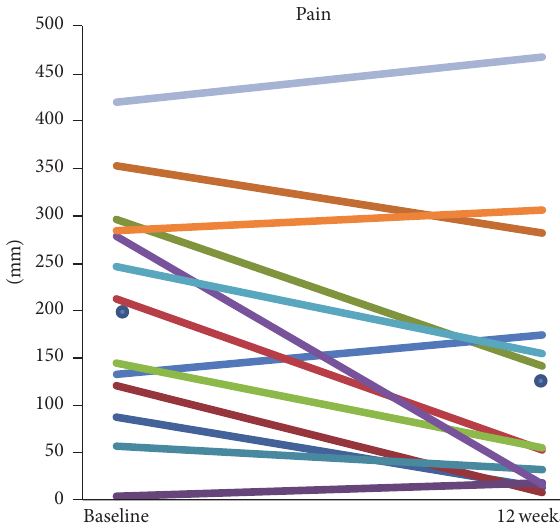
Figure2:IndividualchangesintheWOMACpainscorein12weeks. The mean (SD) pain score at the baseline and 12-week time point is marked with a dot being 202 (123)mm and at 12-week time point 131 (143)mm, respectively (reduction 35%, 𝑝 = 0.002